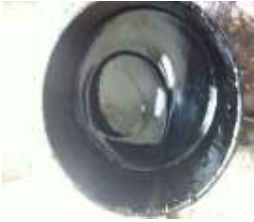
Figure 2. Bio-oil derived from the wood chip.